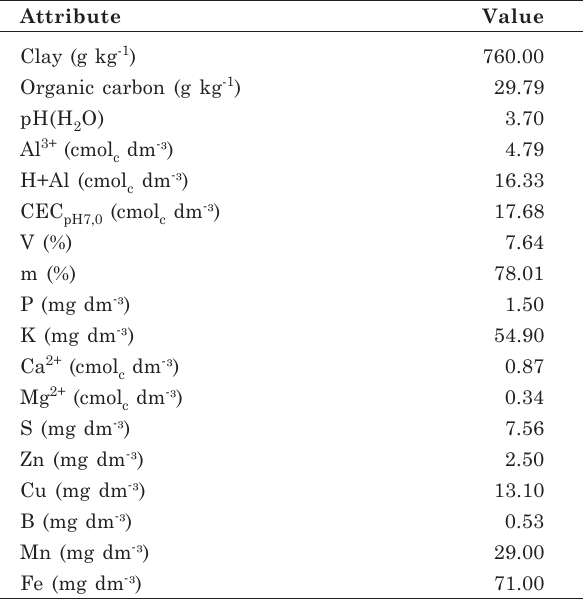
Table 1. Clay content and soil properties in the 0-20 cm layer at the experimental site